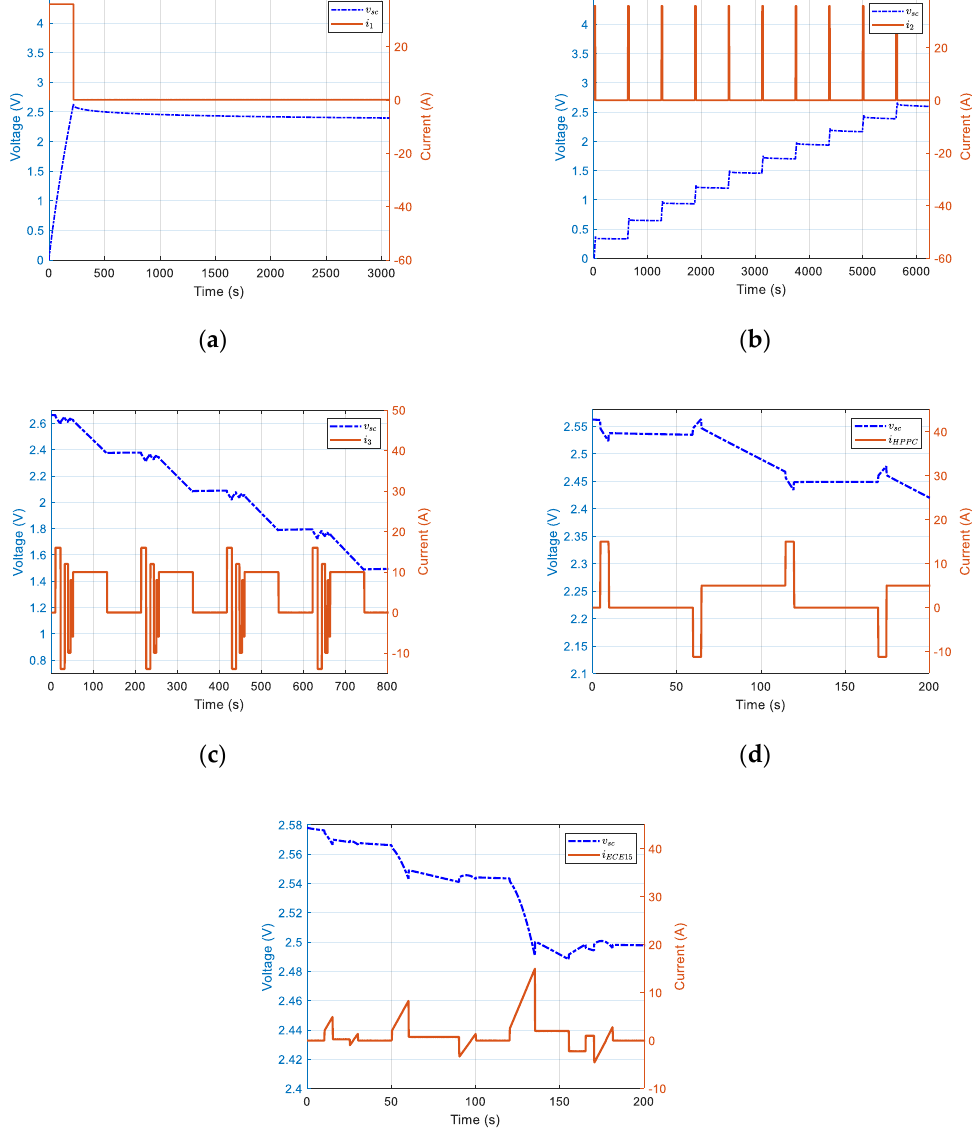
Figure 10. Current profiles and supercapacitor voltage response: ( a ) i 1 ; ( b ) i 2 ; ( c ) i 3 ; ( d ) Verification HPPC profile; ( e ) Verification ECE15 profile.